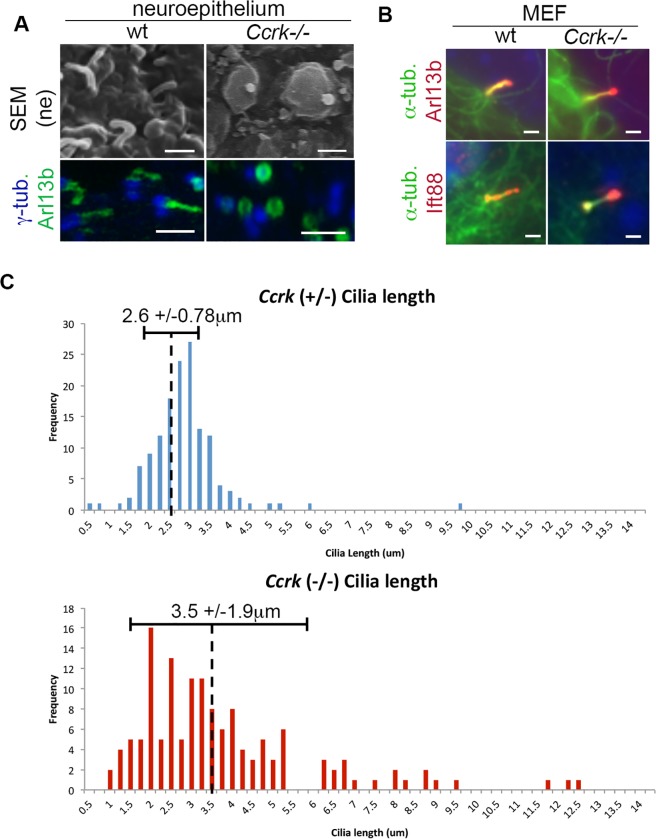
Regulation of ciliary morphology and length by CCRK.(A) Primary cilia in the E9.5 Ccrk mutant and wild-type neuroepithelium assayed by scanning electron microscopy and Arl13b/gamma-tubulin staining. (B) Primary cilia in Ccrk mutant and wild-type MEFs stained with antibodies against acetylated α-tubulin, Arl13b, and IFT88. Scale bars in A and B are 1 μm. (C) Distribution of ciliary length in Ccrk mutant and control (Ccrk+/-) MEFs binned in 0.25 μm groups. Lengths were measured from Arl13b and γ-tubulin-stained cilia. Average lengths and standard deviation for distributions are shown.